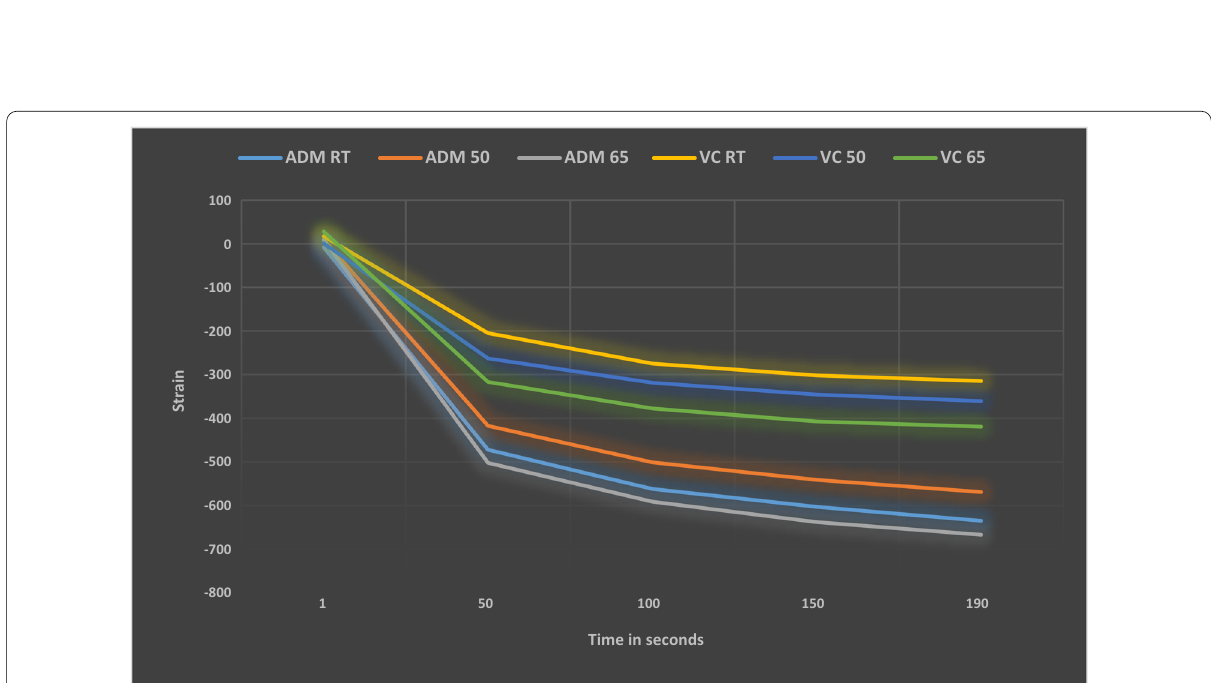
Fig. 3 Curve representing post gel strain versus time of the two different resin composite preheated at different